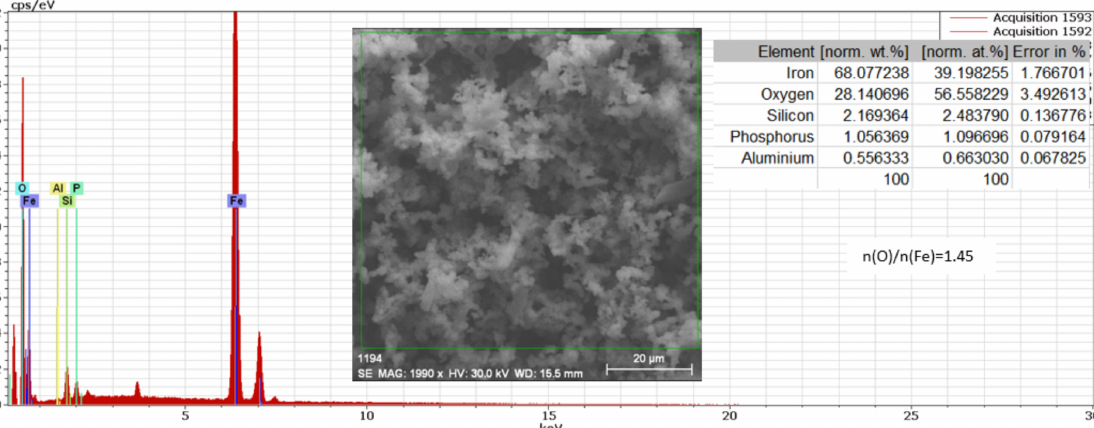
Figure 19. EDS results for the sample immersed for 65 days in DWW-2.